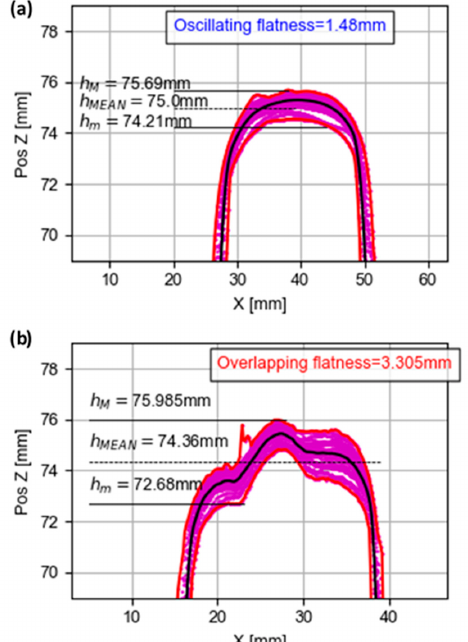
Figure 14. Transversal sections and determination of the flatness in the final piece for the wall manufactured by ( a ) oscillatory and ( b ) overlapping strategies.